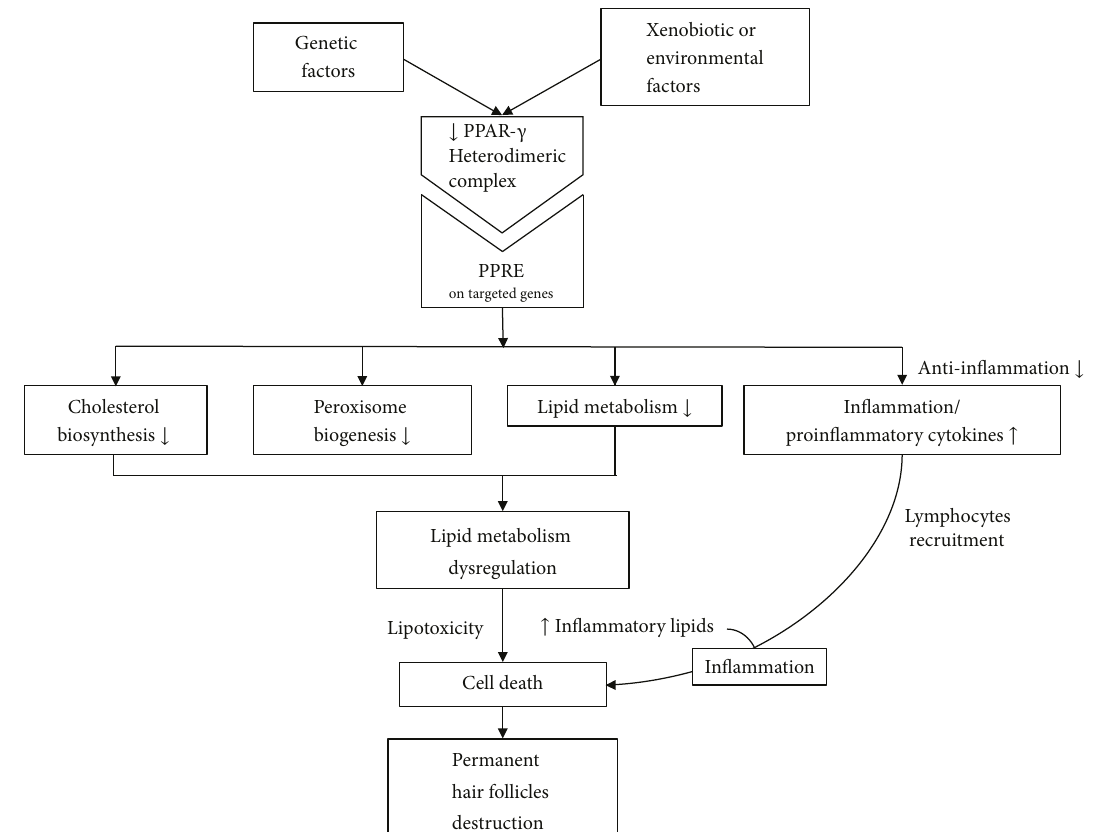
Figure 5: The role of PPAR- 𝛾 in the pathogenesis of primary cicatricial alopecia.